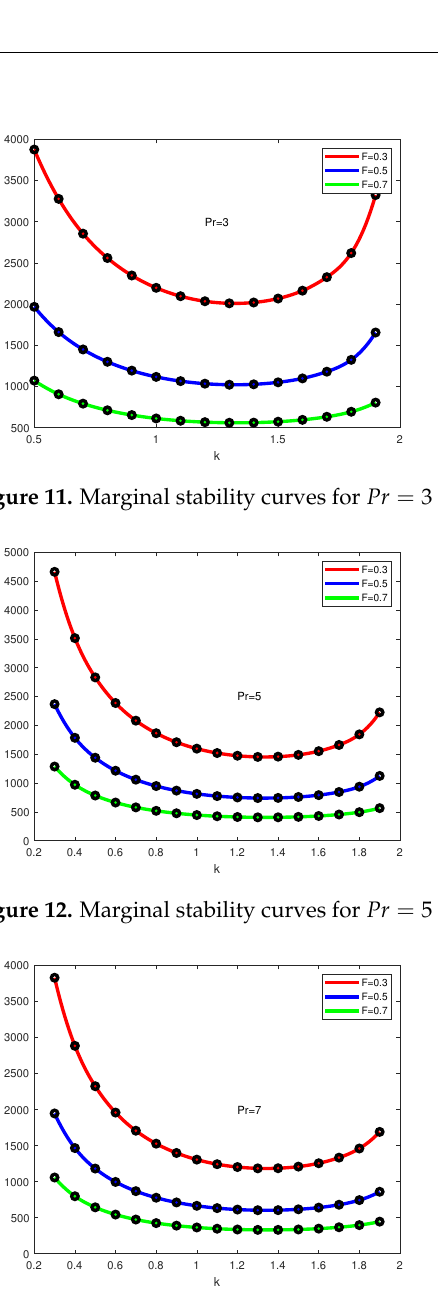
Figure 13. Marginal stability curves for Pr = 7 (case